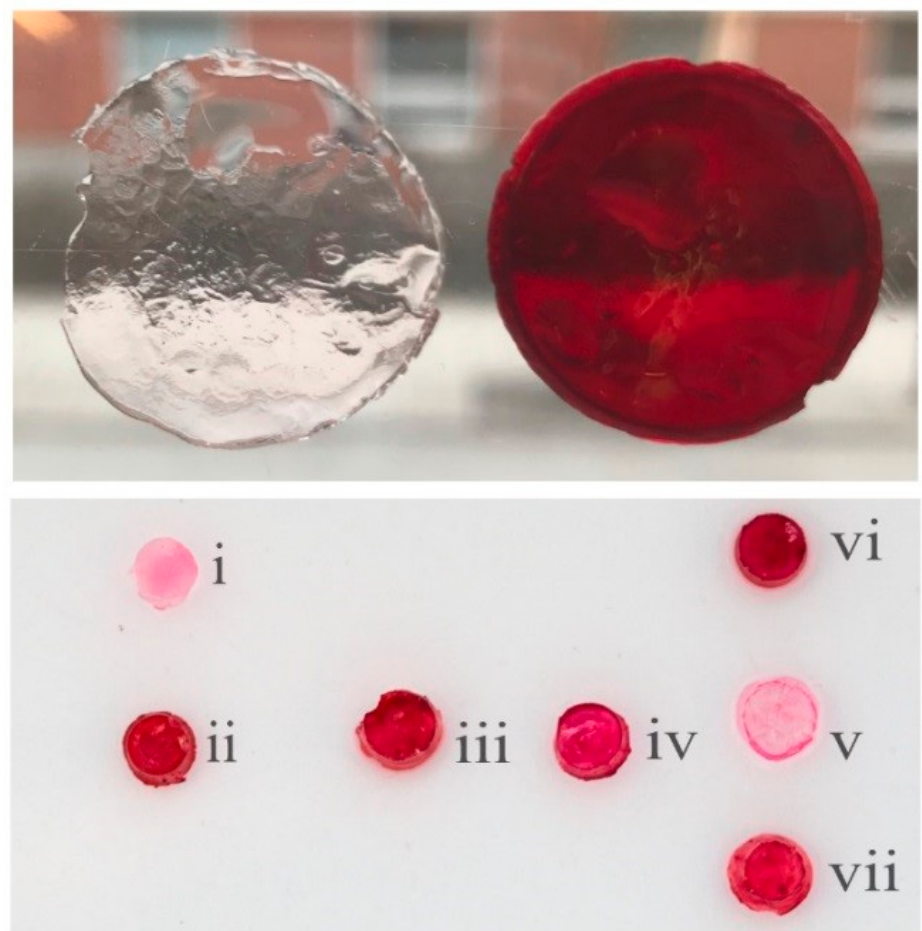
Figure 4. The top image shows a gel made with hydroxyl-functional dendrimers and 10 kDa PEG (left) and amino-functional dendrimers and the same PEG (right). Both gels have been treated with the same amount of NHS-activated dye and washed equal times with solutions of methanol and water. The bottom image shows gels treated with the dye after 8 h (iii), 24 h (iv) and 48 h (v) in pH 7.4 buffers at 37 °C and after 48 h in pH 4.4 at 37 °C (vi) and 48 h in pH 7.4 at room temperature (vii). (i) and (ii) are hydroxyl and amino-functional gels subjected to the dye directly after curing for reference.